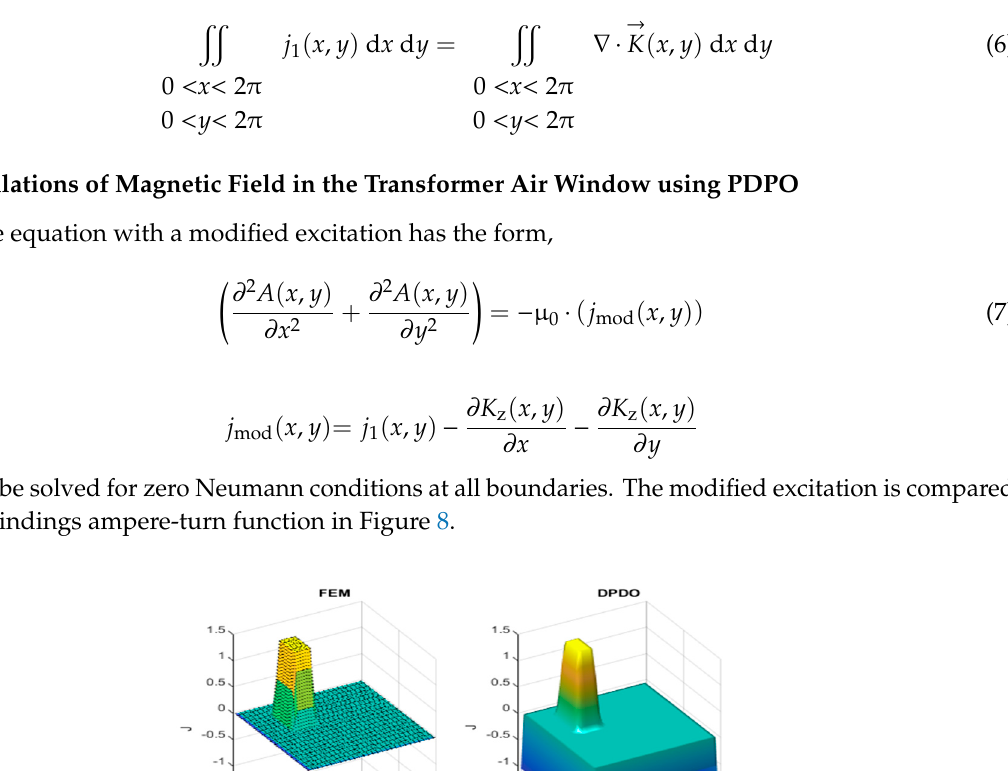
( , ) j x y and the modified excitation 1